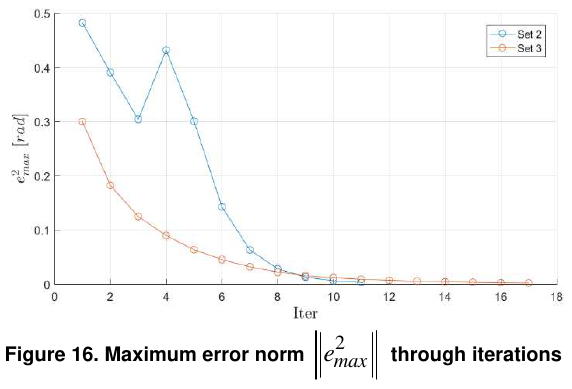
Figure 14. Trajectory tracking q 3 through iterations – set 2